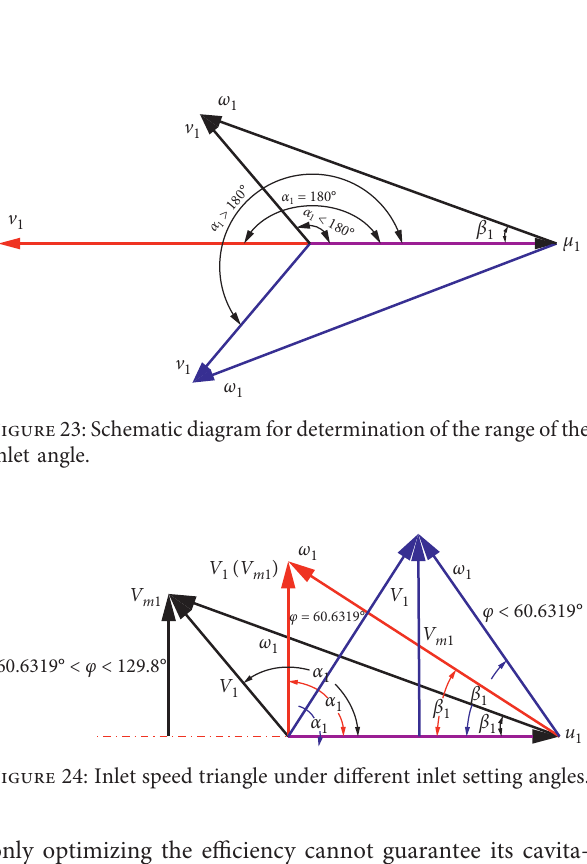
Figure 22: Schematic diagram of blade geometric parameters.